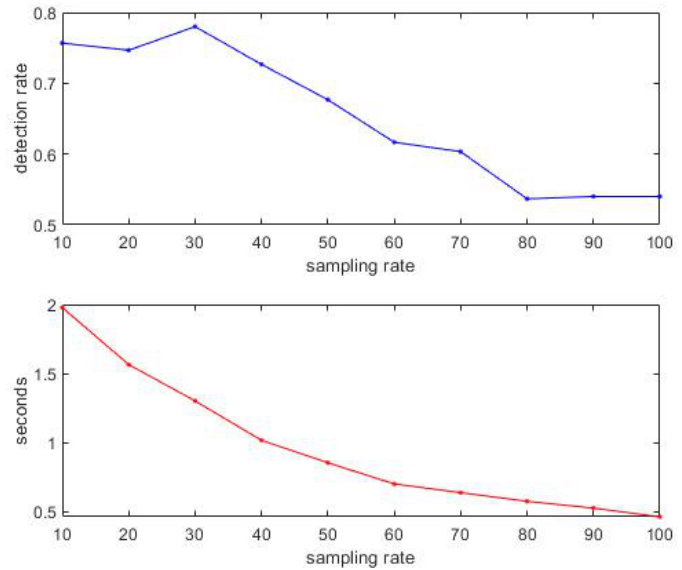
Figure 15. Above : detection rate under different configurations for sampling rate, Below : processing time under different configurations of sampling